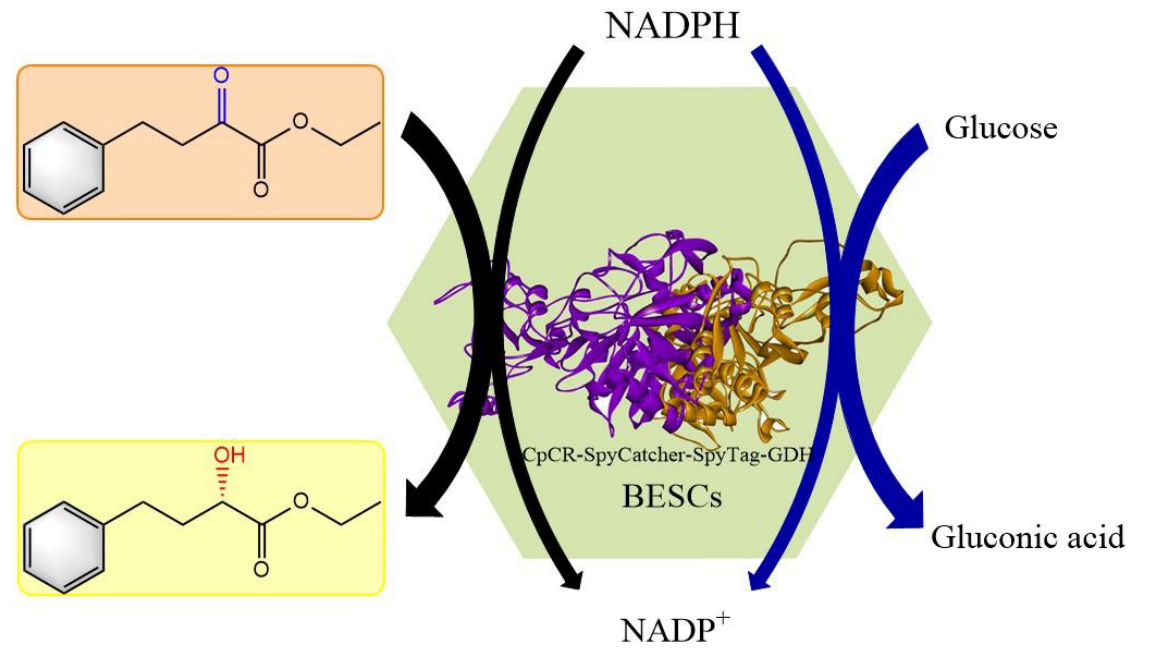
Figure 1. The biosynthesis mechanism of R-HPBE by BESCs. Enzymatic cascade driven by the two biocatalysts.